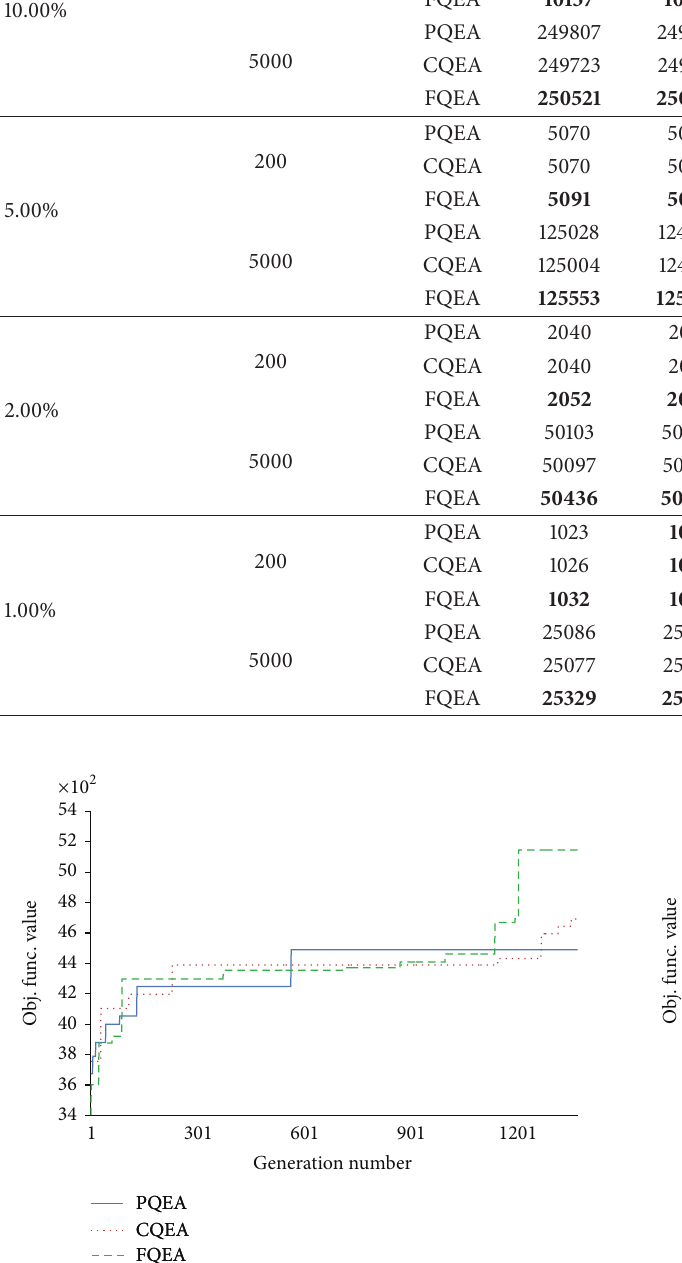
Figure 23: Convergence graph of PQEA, CQEA, and FQEA on 0-1 knapsack problem with multiple strongly correlated data instances with number of items, 𝑀 , being 200 and capacity, 𝐶 , being 2% of total weight.